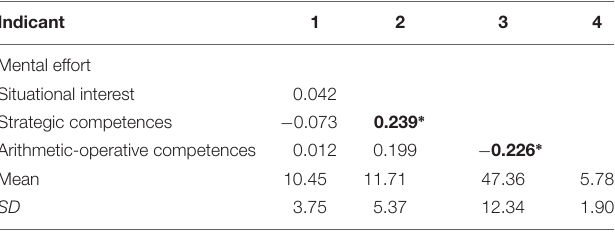
TABLE 1 | Pearson correlations, means, and standard deviations from the scales: Mental Effort, Situational Interest, Strategic Competences, and Arithmetic-Operative Competences ( N =